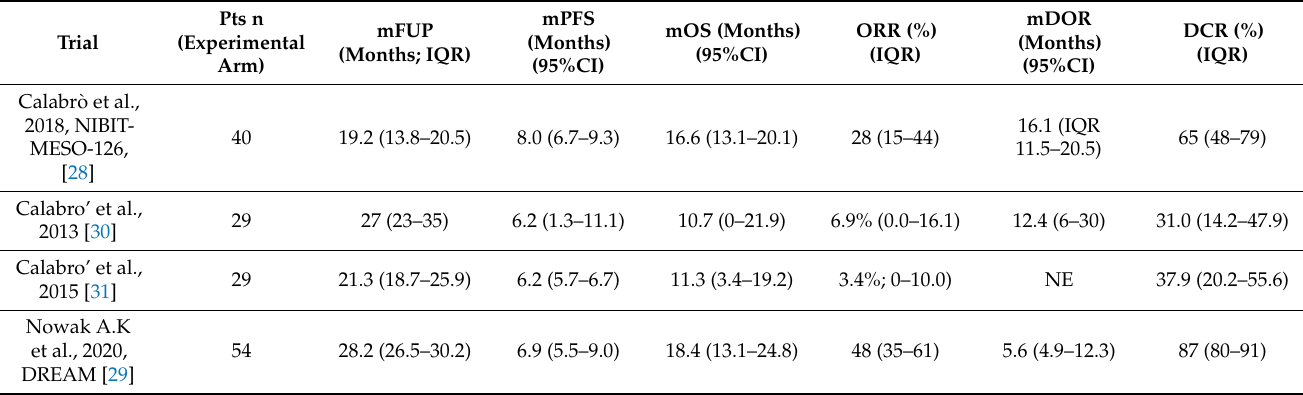
Table 2. Results by endpoint. ORR: Overall Response Rate, PFS: Progression Free Survival, OS: Overall Survival, DCR: Disease Control Rate, CA: Centrally Assessed, IA: Investigator Assessed,